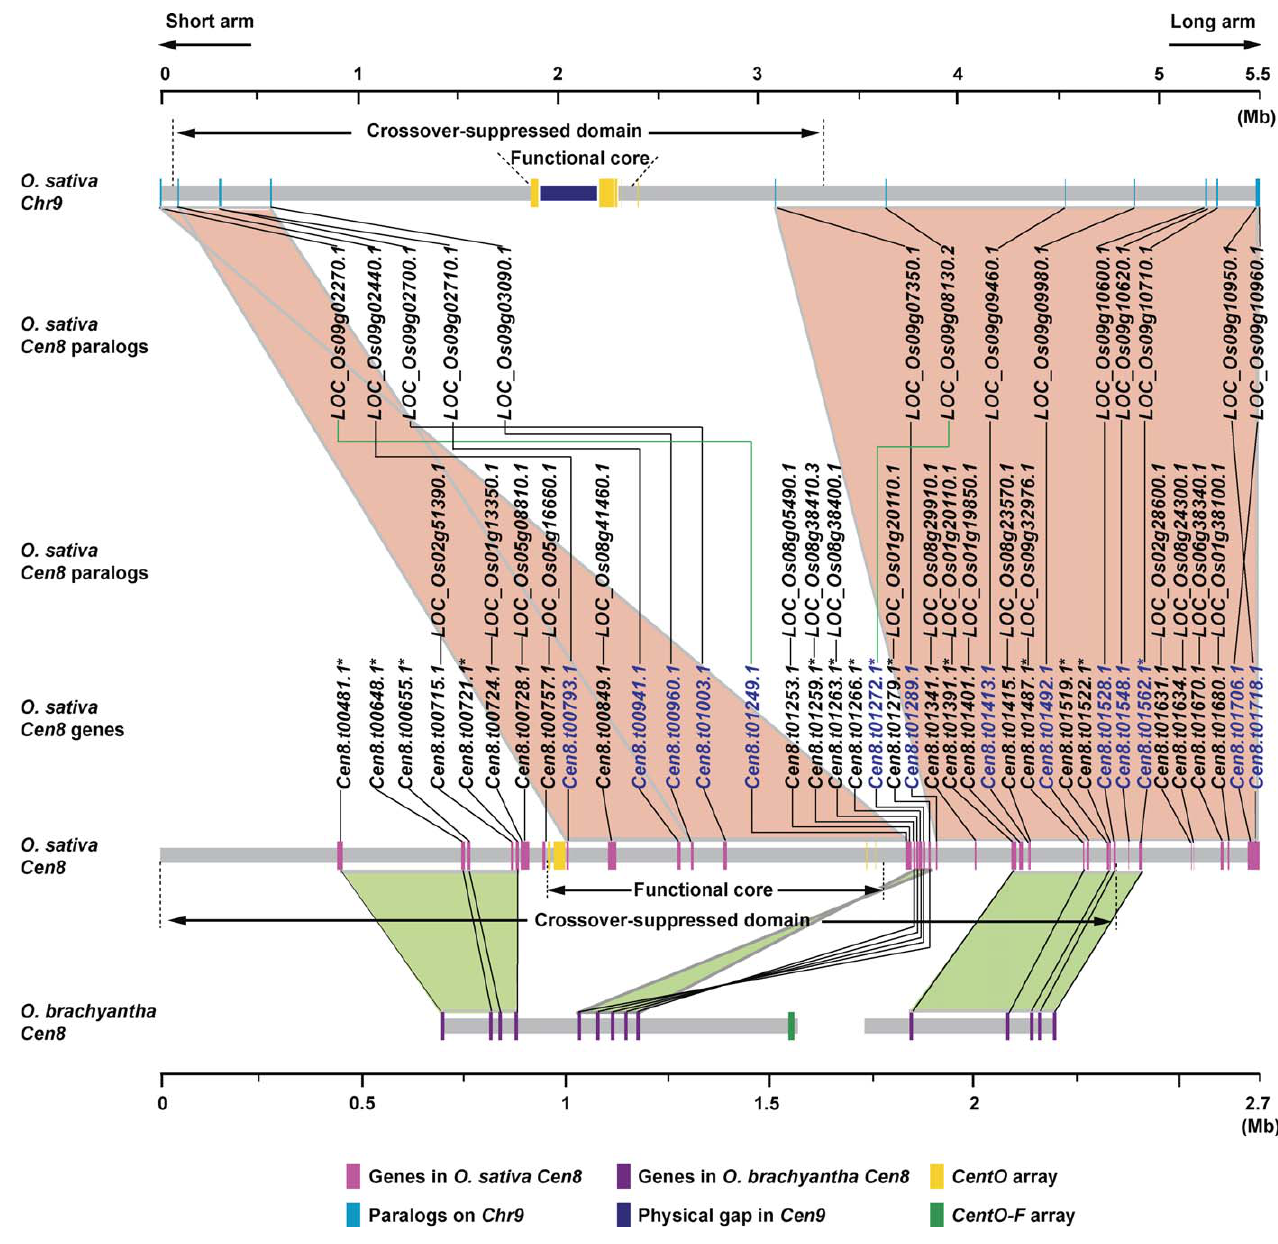
Figure 2. Illustration of Duplication of Cen8 and Cen8 -Associated Genes on Chromosome 9 The approximately 2.7-Mb Nipponbare Cen8 region is displayed at twice the scale as that of the 5.5-Mb chromosome 9 region. A total of 32 active genes located in Cen8 were used for comparative mapping and analysis. Twenty-seven of the paralogs have cognate ESTs or full-length cDNAs (http://rice. plantbiology.msu.edu/); expression of the others was confirmed by RT-PCR (unpublished data), with the exception of Loc_Os09g10620.1 , whose transcription was not tested. Two syntenic blocks with five and nine paralogs of Cen8 genes (gene names in blue), respectively, were identified on chromosome 9, separated by a distance of approximately 2.5 Mb containing the chromosome 9 centromere core. Another 18 Cen8 genes had paralogs elsewhere in the genome (displayed below the chromosome 9 paralogs). The order of Nipponbare Cen8 gene orthologs (indicated by an asterisk [*]) flanking the O. brachyantha satellite array is shown at the bottom [24].